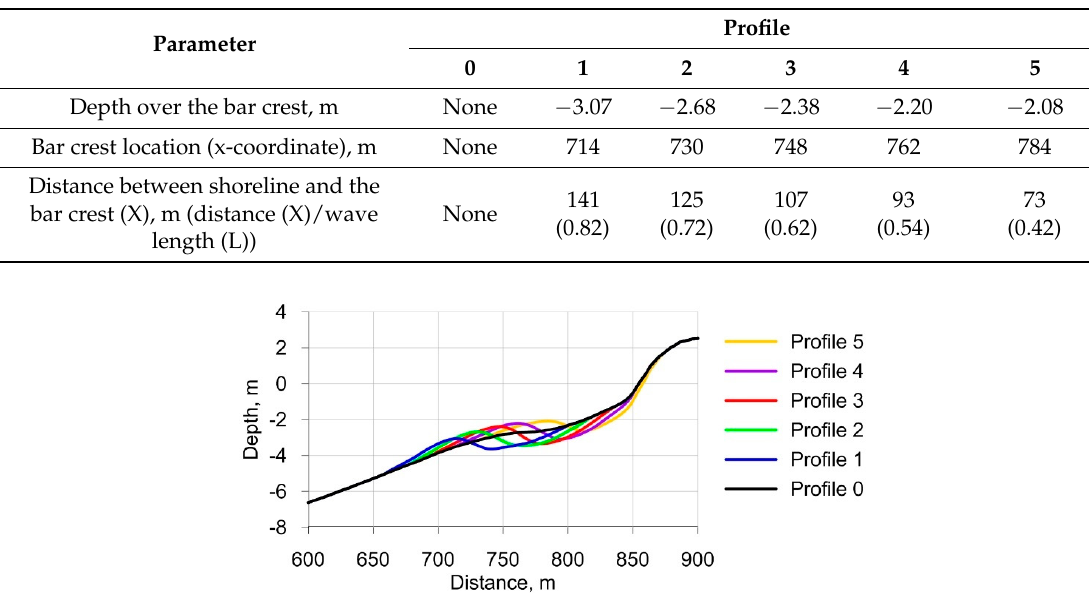
Figure 2. The cross-shore profiles used as the model bathymetry input. Table 1. Parameters of the initial profiles.